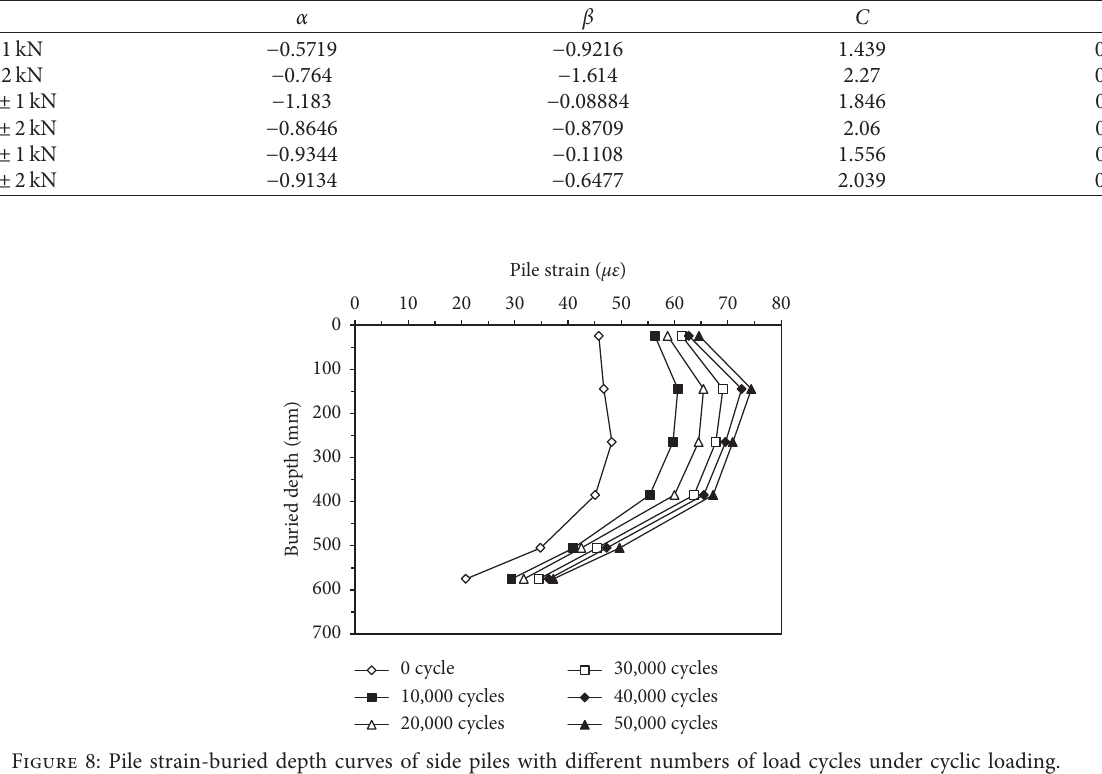
Table 3: Fitting values of α , β , constant C , and coefficient of determination R 2 .